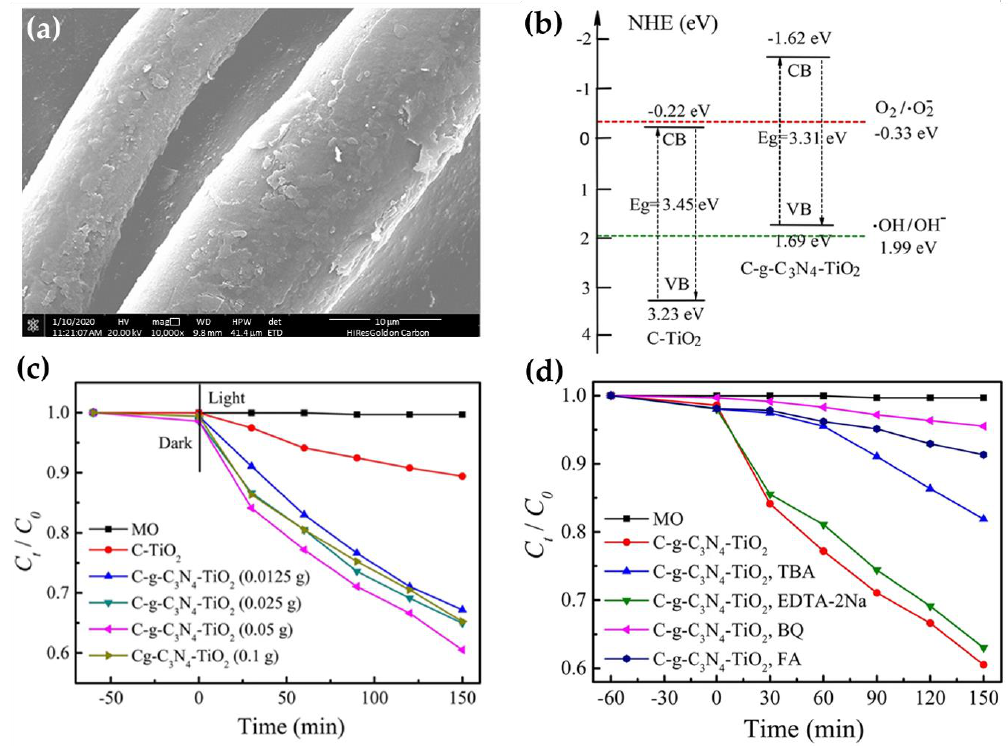
Figure 10. FESEM images of C–g-C 3 N 4 –TiO 2 cotton fibers ( a ); schematic diagrams of energy band structure for C–TiO 2 and C–g-C 3 N 4 –TiO 2 cotton fibers ( b ); photodegradation of MO dye solution by the C–g-C 3 N 4 –TiO 2 cotton fibers ( c ); trapping experiments for the photodegradation of MO dye solution by C–g-C 3 N 4 –TiO 2 cotton fibers ( d ). Reprinted with permission from [39]. Copyright 2021, Springer Link.